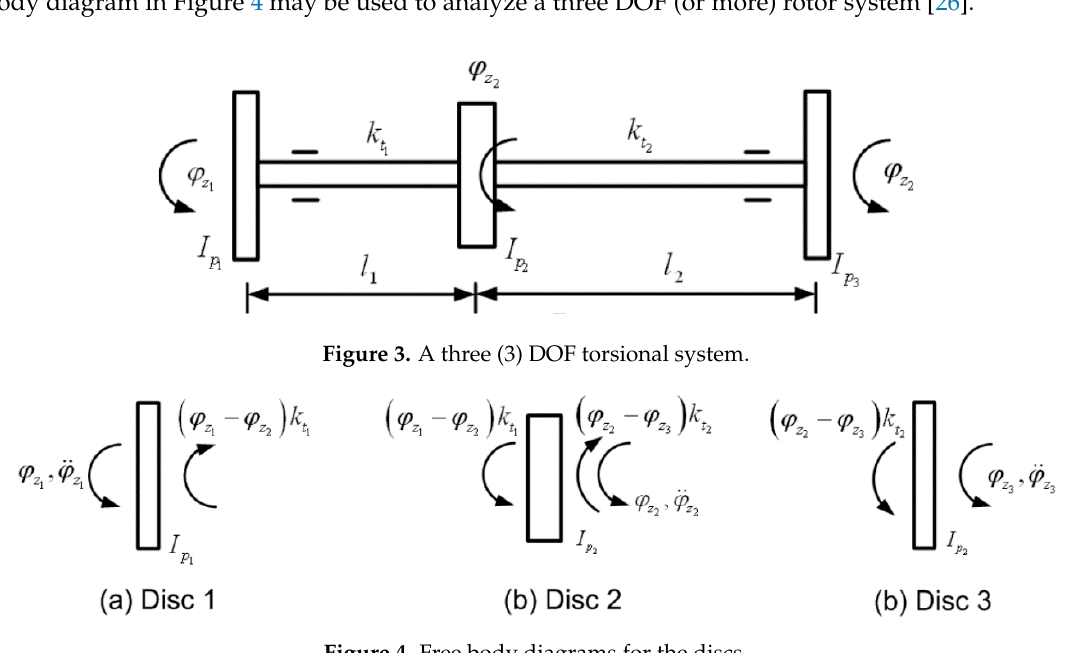
Figure 4. Free body diagrams for the discs.